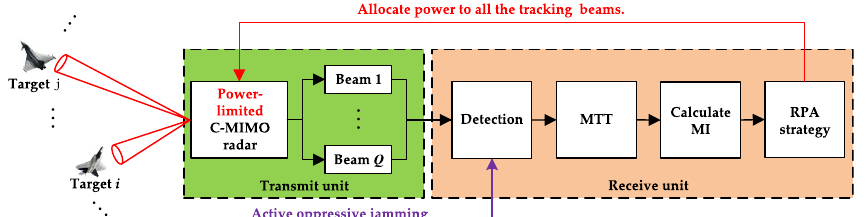
Fig. 1 Illustration of the proposed cognitive tracking scheme for RPA